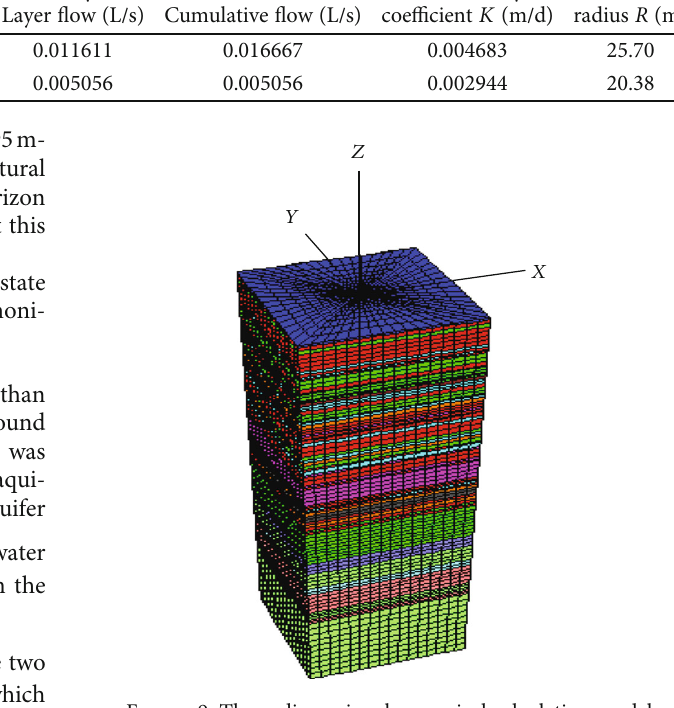
Figure 9: Three-dimensional numerical calculation model.